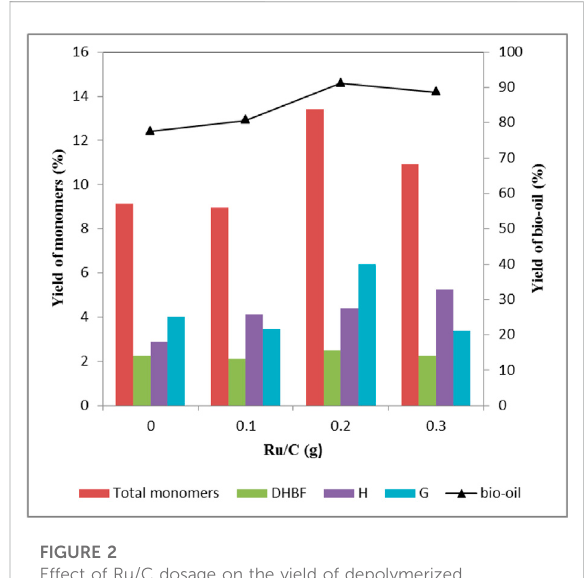
FIGURE 2 Effect of Ru/C dosage on the yield of